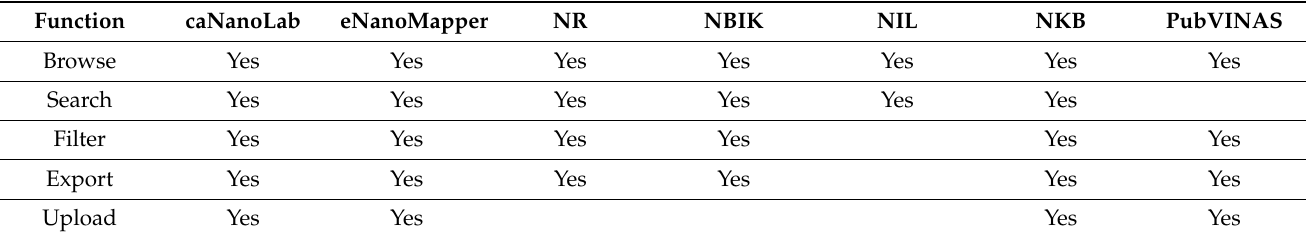
Table 3. Nanomaterials in the seven